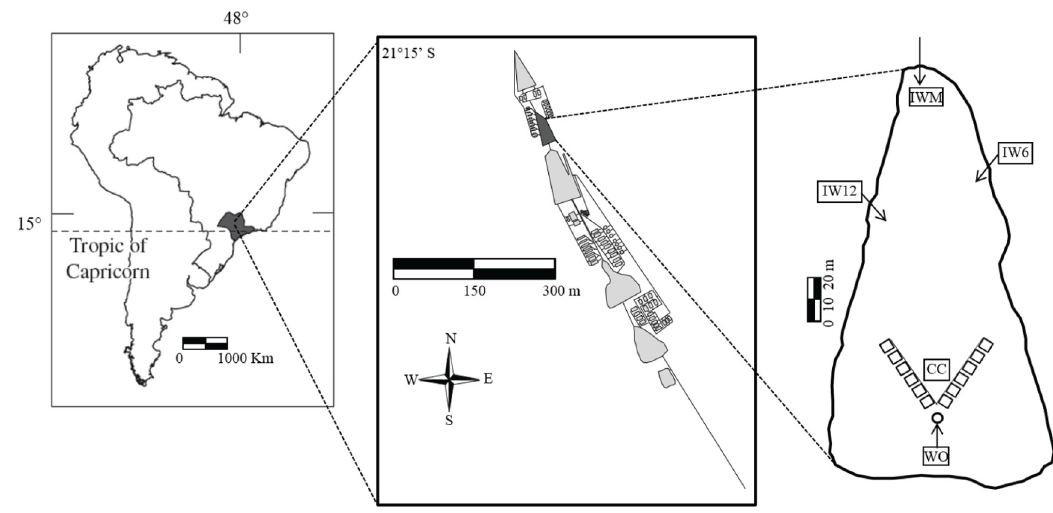
Figure 1. Location of the fishpond studied. CC= close to cages in the open-pond; WO= water outlet; IW12= water inlet receiving effluents from 12 fishponds; IW6= water inlet receiving effluents from 6 fishponds; IWM= water inlet opening into a macrophyte